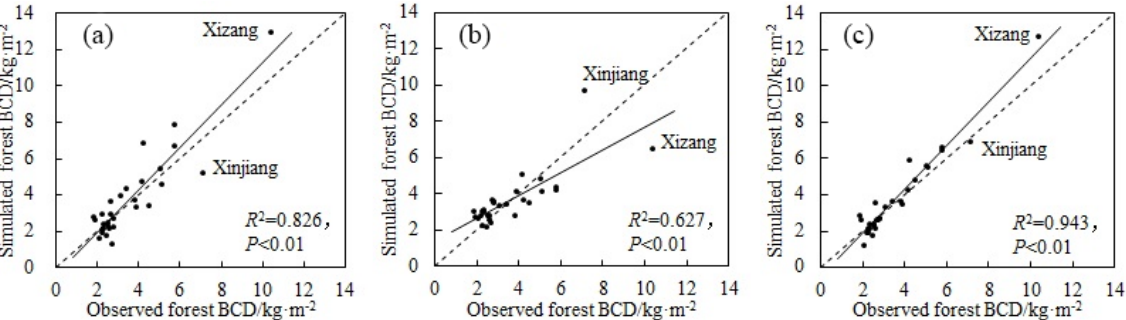
Figure 6. The scatter diagrams of simulated BCD against observed BCD: (a) Kriging, (b) SOA, and (c)